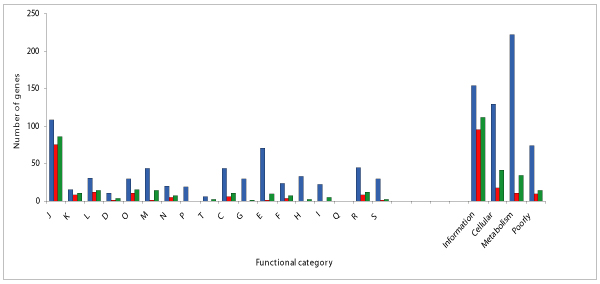
Comparisons (RF distances) between concatenate trees, by functional category, and the reference tree. The phylogenies for concatenates of genes in the 'essential' and 'universal' cores and functional category were derived by maximum likelihood. Cases marked with an asterisk indicate that no genes were present in the corresponding category for the 'essential' core.